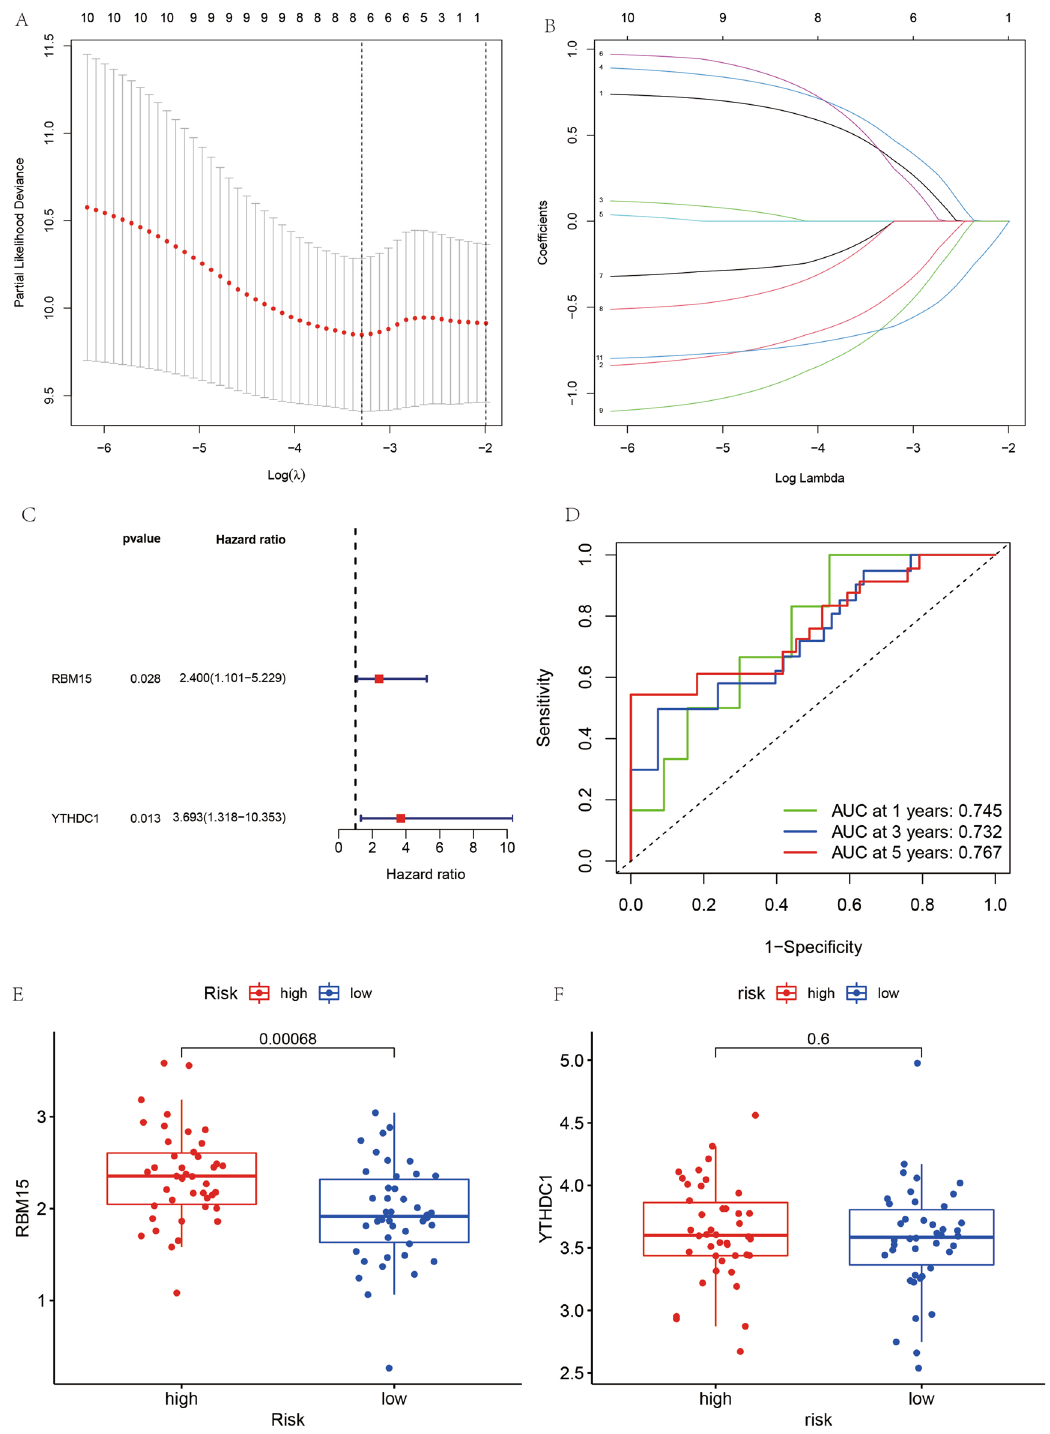
Figure 7. Construction diagram of the prognostic model for osteosarcoma. ( A ) and ( B ) represent the results of LASSO regression analysis to find the minimum penalty coefficient. ( C ) Shows the results of multivariate COX regression analysis, plotting the forest plot of 2 genes for constructing the prognostic model of osteosarcoma. ( D ) Represents the ROC diagnostic curve. ( E ) and ( F ) indicate the expression of the two genes used to construct the model in the high and low risk